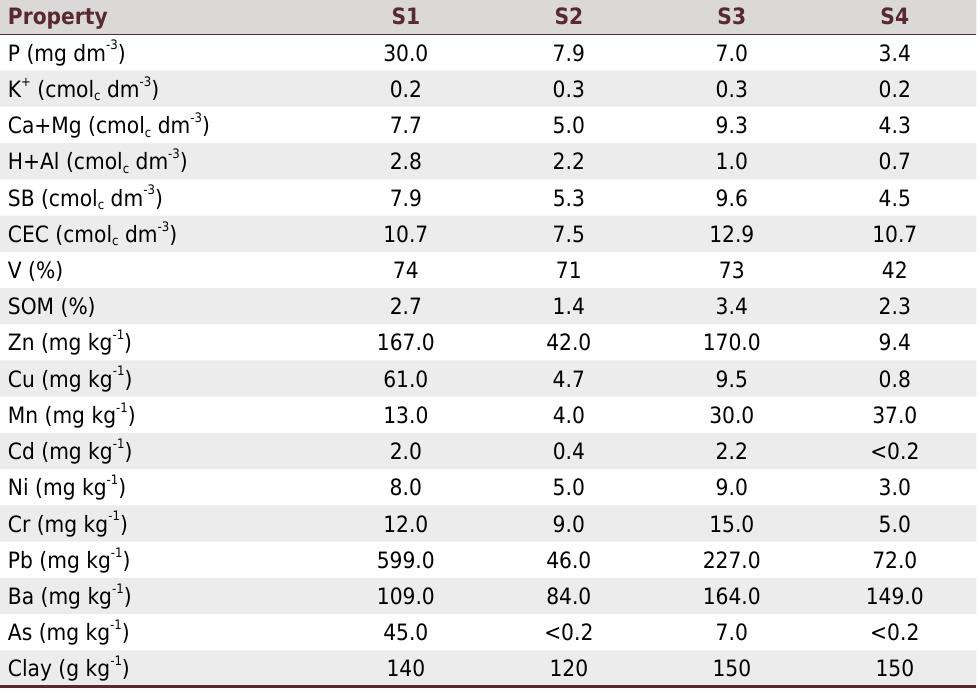
Table 1. Chemical and physical characterization of soil samples (S1, S2, S3 and S4) from a multi-metal contaminated site Property